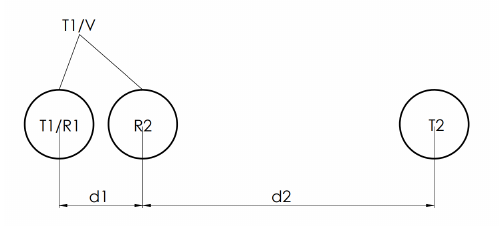
Figure 4. Sensor configuration [14].